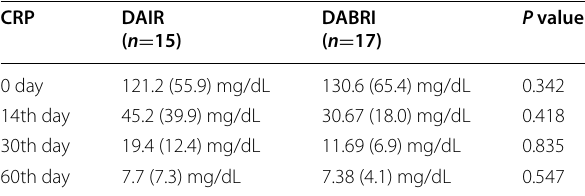
Table 5 C-reactive protein variations in 32 patients